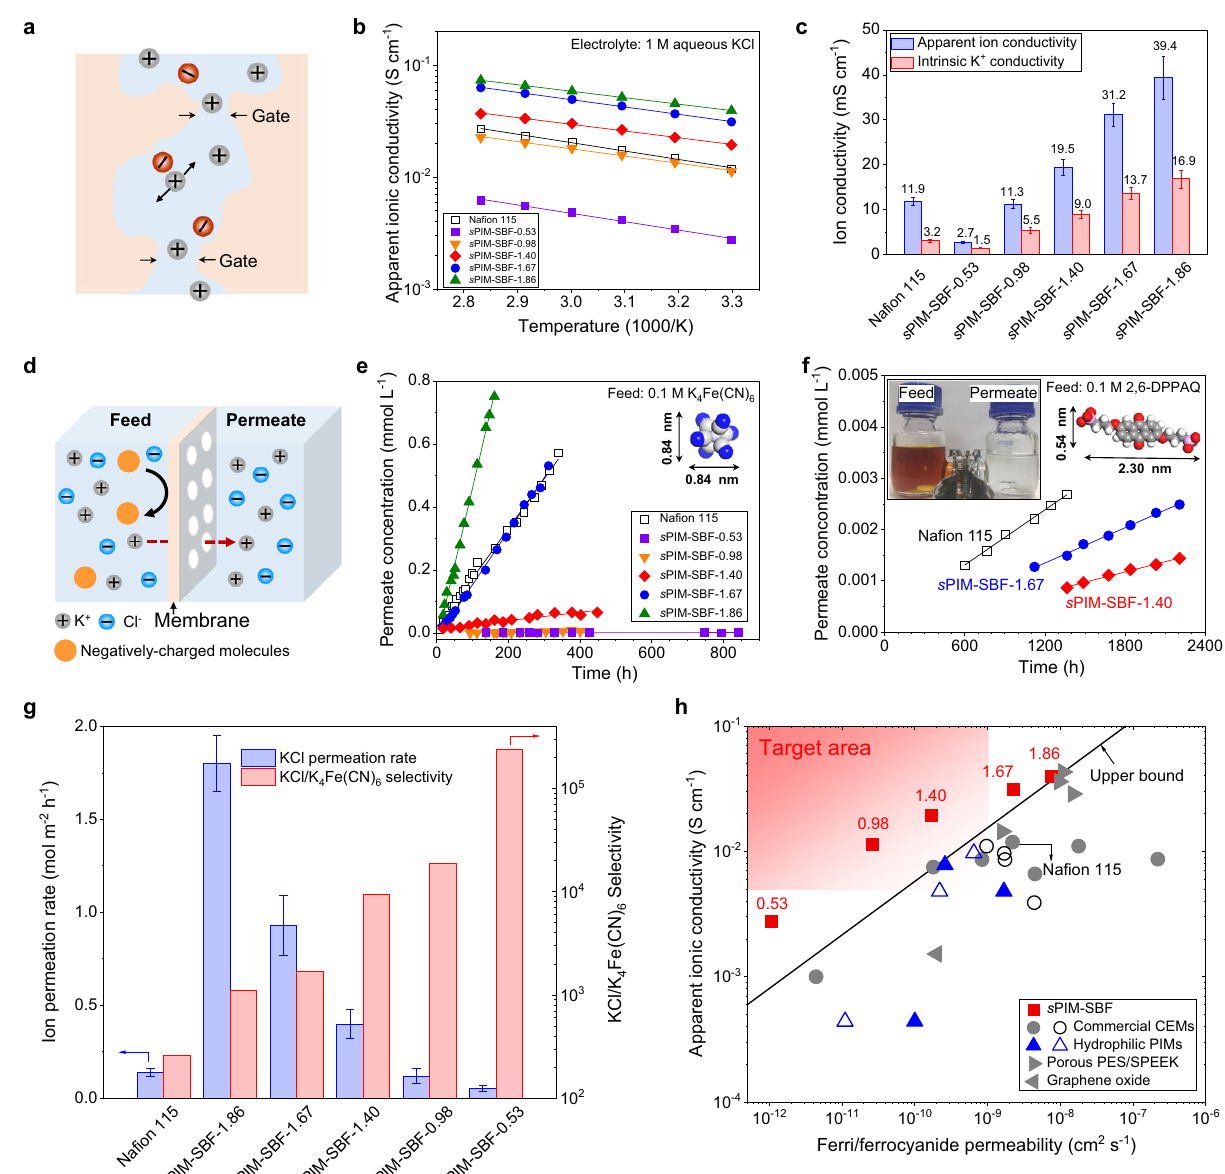
Fig. 3 Ion conduction and molecular sieving properties. a Schematic of the subnanometer pores (<1nm) within s PIM-SBF membranes for fast ion transport. b Temperature dependence of apparent ionic conductivity measured by EIS in 1 M aqueous KCl. c Apparent ionic conductivity measured in 1M aqueous KCl and intrinsic K + ionic conductivity measured in deionised water at 30 °C. Error bars are standard deviations derived from three ionic conductivity measurements based on three different membrane samples. d Schematic illustrating the transport of small K + , Cl - ions through the ion-selective membrane and sieving of large redox-active molecules. e K 4 Fe(CN) 6 and f 2,6-DPPAQ concentration in the permeate side of dialysis diffusion H-cells assembled with s PIM-SBF or Na fi on 115 membranes as a function of time. Inset photograph showing the colors of feed and permeate solution in a H-cell assembled with s PIM- SBF-1.40 membrane after 3-month dialysis diffusion test. Data in e and f are linearly fi tted to derive permeation rates and fi tted lines are presented in the fi gures. g KCl permeation rate and KCl/K 4 Fe(CN) 6 selectivity.Errorbarsof ion permeation rate are derived from three individual measurements based on three different samples. h Upper bound plot for ferro/ferricyanide permeability versus apparent ionic conductivity. Typical data reported previously in literature are included for comparisons such as those of commercial membranes including Na fi on 212 and 115 31,33 , Fumasep E610 12 , Selemion CSO 43 , and Celgard 3501 30 , and those of recently reported ion-sieving membranes including porous PES/SPEEK 44 , AO-PIM-1 and PIM-EA-TB 31 , Graphene oxide 45 , and SPX-BP-0.95 membranes 33 . The line represents an empirical upper bound for the trade-off between ionic conductivity and permeability of redox-active molecules for previously reported membranes. Solid symbols represent permeability data derived from dialysis diffusion tests and open symbols correspond to these derived from RFBs in operation. The values of IEC are labeled near the corresponding s PIM-SBF membrane symbols. tortuous ion channels. Apparent ionic conductivity of s PIM-SBF highest IEC value of 1.86 mmol g − 1 showing the highest ionic membranes was measured with 1 M aqueous KCl (Fig. 3b), as an conductivity of 3.9 × 10 − 2 S cm − 1 at 30 °C and 7.4 × 10 − 2 S cm − 1 indication of the values for RFBs operated using the same sup- at 80 °C. The low activation energy for ion transport in s PIM- porting electrolyte. Apparent ionic conductivity is linearly cor- SBF-1.86 (0.07 eV, Supplementary Fig. 20) suggests thermally related with sulfonate content of s PIM-SBF membranes with the controlled ion dynamics in s PIM-SBF membranes where energy NATURE COMMUNICATIONS| (2022) 13:3184